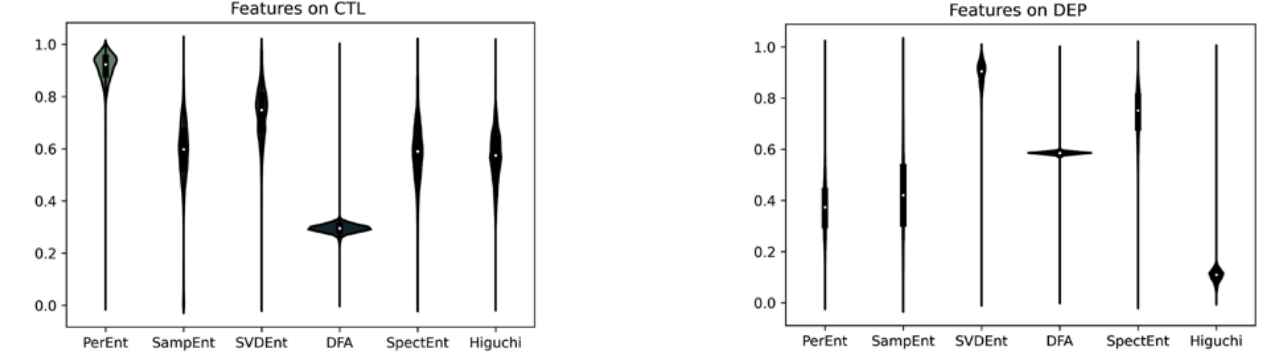
Figure 3. Distributions of values of non-linear features. Permutation entropy (PerEnt), sample entropy (SampEnt), single-value decomposition entropy (SVDEnt), detrended fluctuation analysis (DFA), spectral entropy (SpectEnt), and Higuchi’s fractal dimension (Higuchi). Left : CTL. Right : DEP.